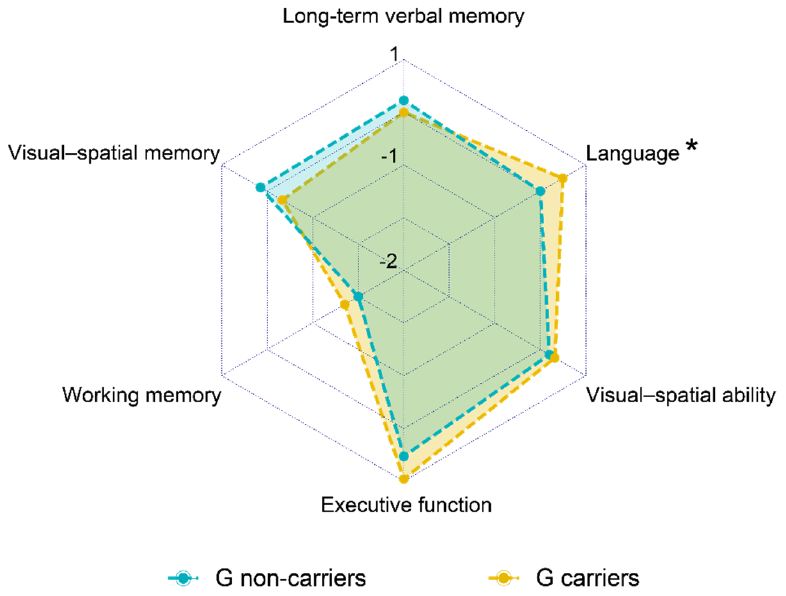
Figure 1. Comparison of composite score for each cognitive domain between G carriers and G non-carriers. Values quoted in the axis are median values. Language composite score (*) was higher in G carriers as compared to G non-carriers (0.25 [IQR 0.94] vs. 0.62 [IQR 0.52], p = 0.018). Table 2. Logistic regression model for multivariate